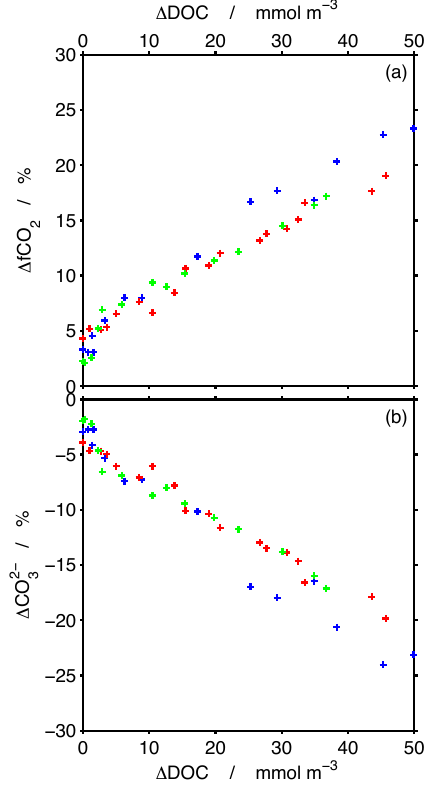
Fig. 3. (a) Relationship between DOC accumulated during the ex- periment ( 1 DOC) and (a) 1f CO 2 and (b) 1 [CO 2 − as in Fig. 1, 1f CO 2 and 1 [CO 2 −